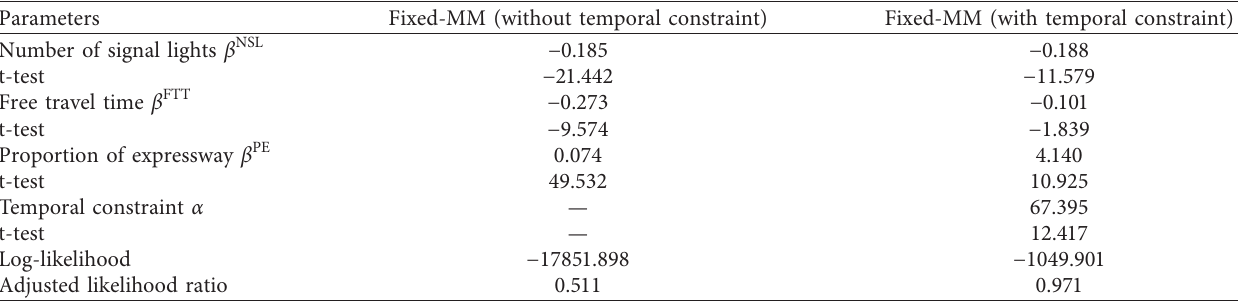
Table 3: Estimation results of